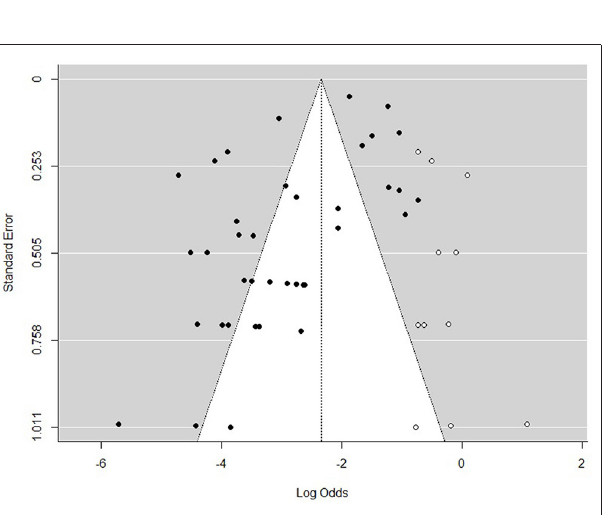
the AMR of Klebsiella spp. isolated from bovine mastitis in China. For these nine antimicrobials, the resistance rate of sulfonamides was the highest (45.07%), followed by